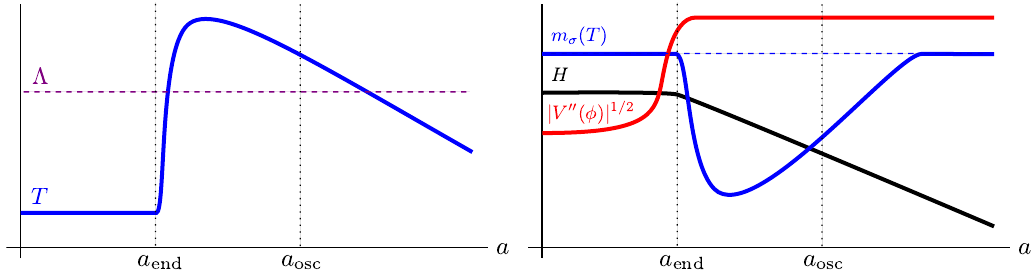
Figure 2 . Schematic of the time evolution of the cosmic temperature (left) and scalar (cid:12)eld masses (right) in the in(cid:13)axion scenario under consideration (not to